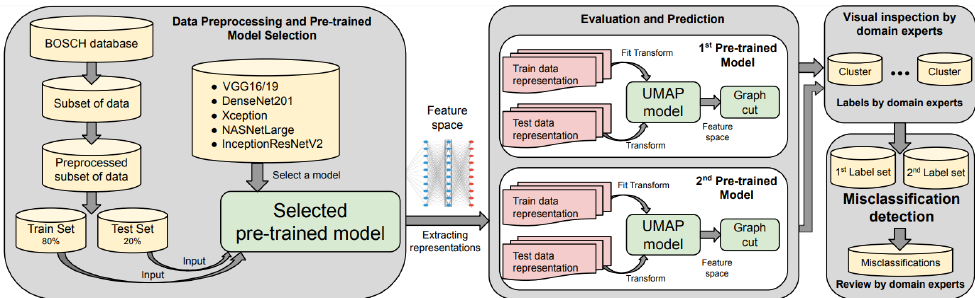
Figure 1. Pipeline for domain experts to evaluate their own dataset. On the left, the first stage can be seen as the Data Preprocessing and the Pre-trained Model Selection for further evaluation. The train and test subsets are fed into the selected pre-trained model for feature extraction. The second stage is the Evaluation and Prediction, where the UMAP method is applied on the train and test sets’ representations independently, then a graph cut technique is used to define the most accurate clustering result. The next stage is the Visual Inspection by the domain experts, who supervise the results and reinforce the given labels. The final stage is Misclassification detection, where the two best performing pre-trained models classify the images and only those images that they disagree on are sent back to the domain experts for a final